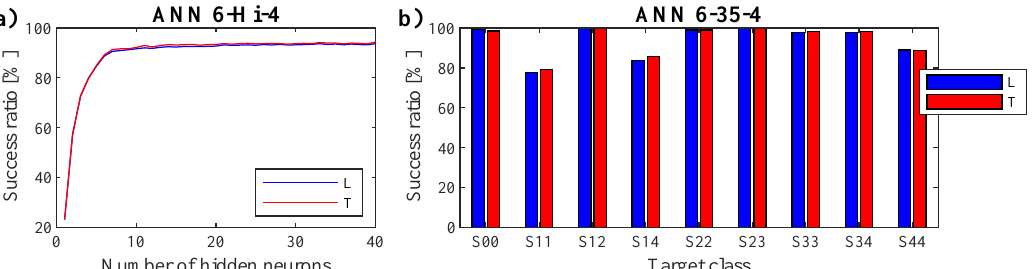
Figure 6. ( a ) Optimization of hidden neurons number for ANN 6-Hi-4 for the detection of bolt loosening in consecutive rows based on six affine transformation parameters, ( b ) the success ratio for ANN in the architecture 6-35-4, considering the class of anomaly; L: learning; T: